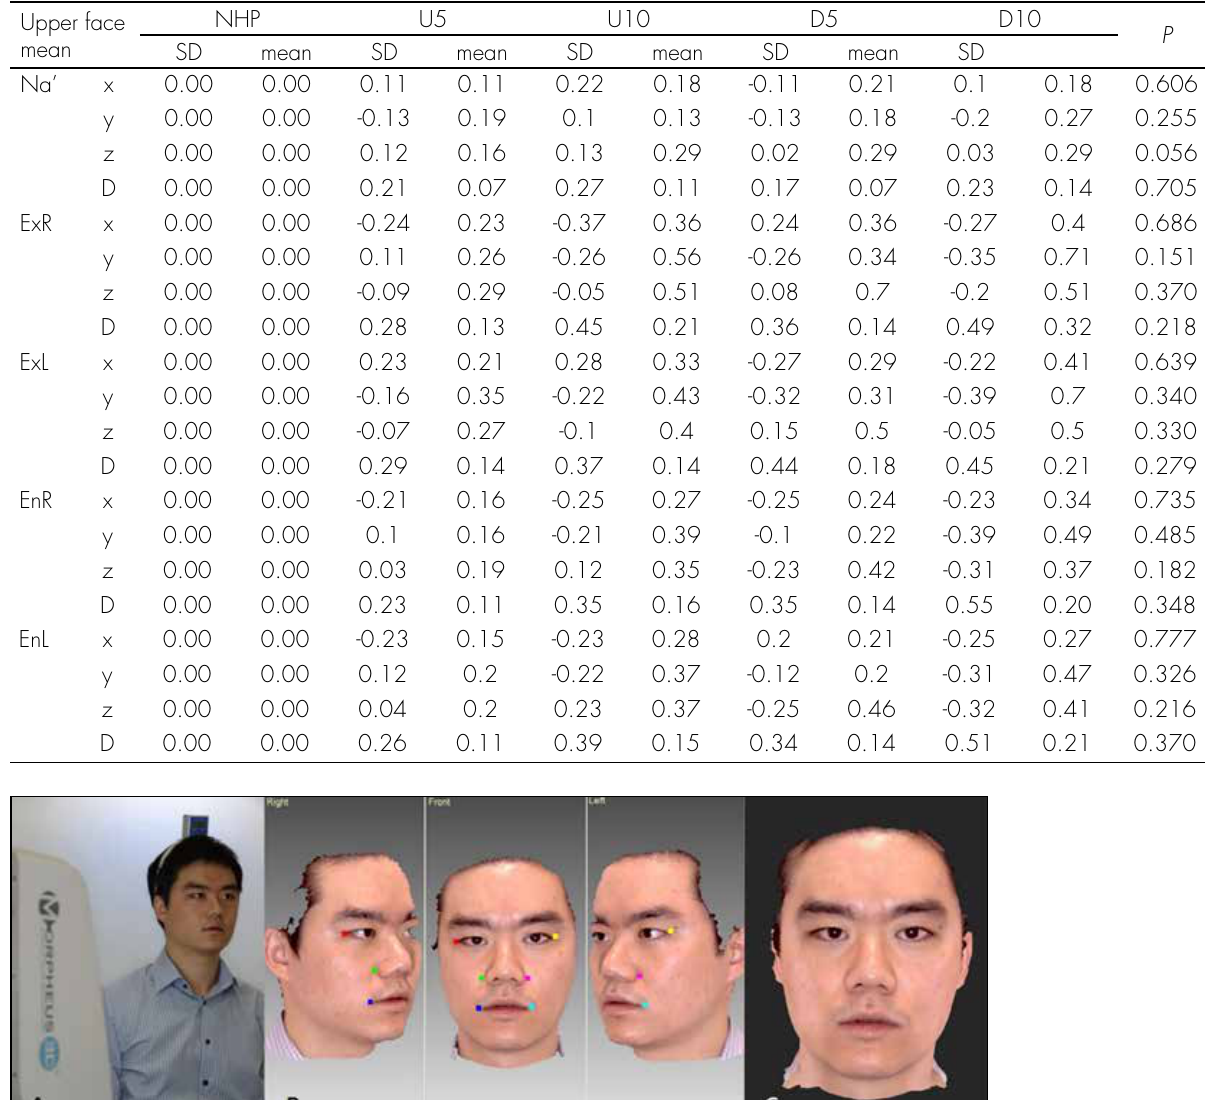
Table II. Changes in the upper facial soft tissue landmarks according to head posture